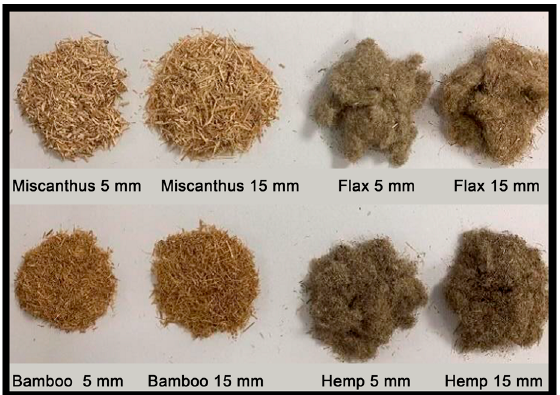
Figure 1. Fibers used in the research.